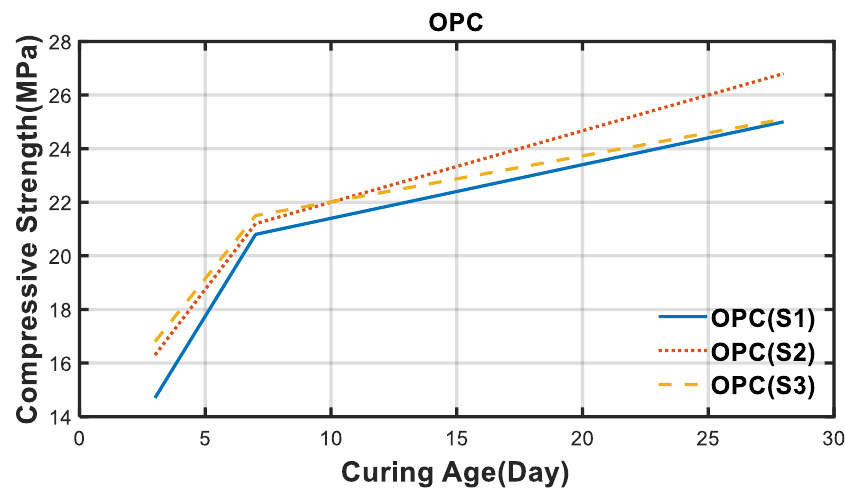
Figure 5. Graph of strength measurement results between OPC specimens.